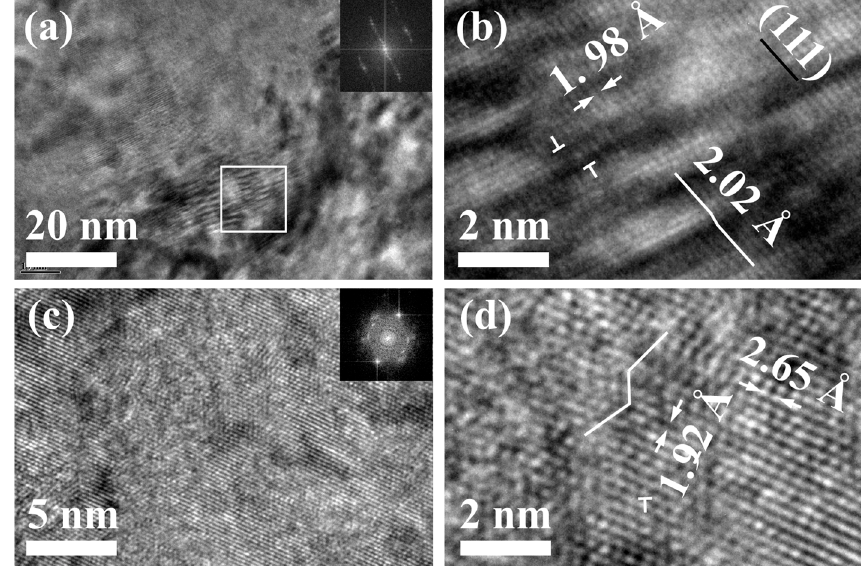
Figure 6. A typical ( a ) TEM image and ( b ) high-resolution TEM image of the as-welded Fe–Ni samples with a Fourier transformation of the white rectangle at the top-right corner shows the slip deformation, and the inverse Fourier-filtered image from inside the white rectangle ( c ) in ( a ), and ( d ) in ( b ) shows slip deformation, Stacking Faults (SFs) (white lines), and dislocations (white T). Adapted from [69], with permission from Elsevier, 2017.